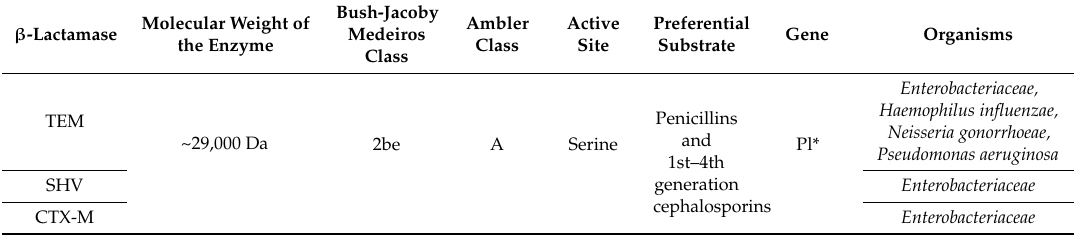
Table 1. Classification of TEM, SHV and CTX-M β -lactamases. Adapted from [27]. β -Lactamase Molecular Weight of the